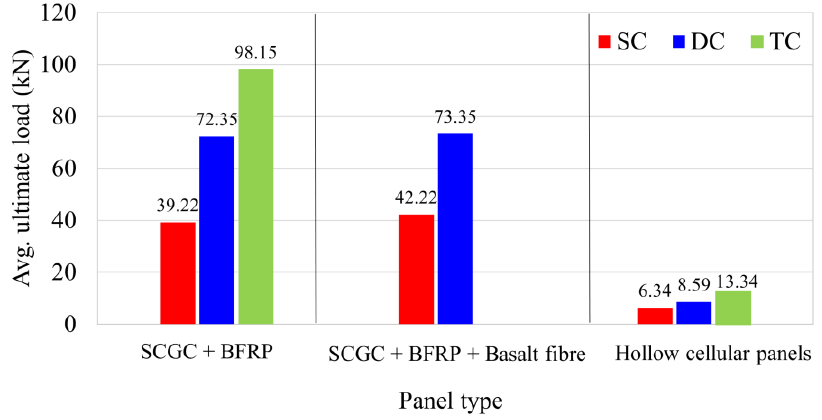
Figure 14. Summary of ultimate load capacity of various configurations of test panels.